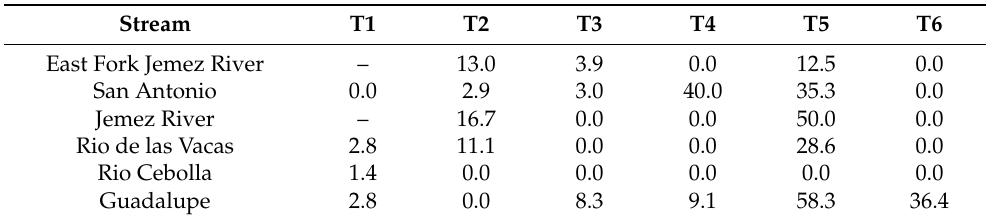
Table 1. Percentage of Brown Trout ( Salmo trutta ) diets containing fish in streams of the Jemez River watershed, New Mexico (USA). Sampling occurred every 14–21 days from 7 July through 1 October of 2020. T = sampling